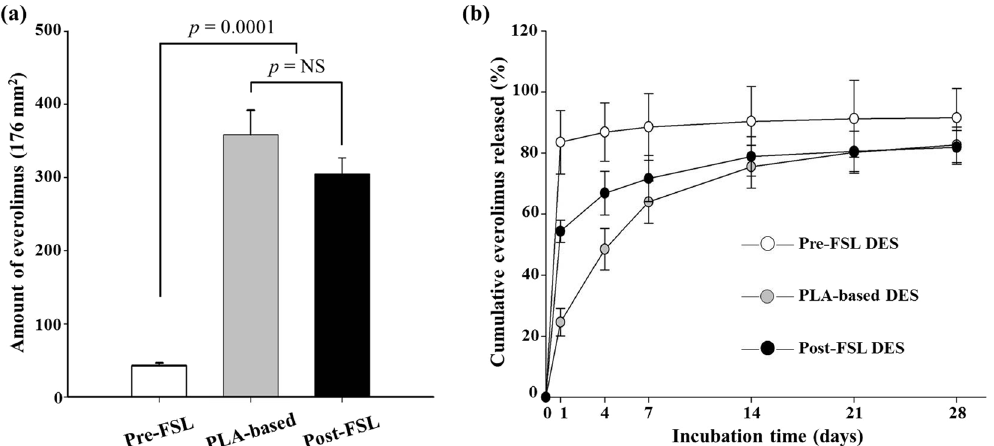
Figure 5. Amount of everolimus on surfaces and in vitro release velocities. The amount of EVL on the stent surfaces after washing with PBS. ( a ) In vitro cumulative EVL released from surfaces. ( b ) The amount of everolimus was measured using UV-visible spectrophotometer at designated time points. The indicated values are expressed as the mean ± SD (n = 10). NS, not statistically of 3-D tubular shaped stents (Fig. S1). In such an equipment system, by adjusting the condition of the jig that is being held, the interval of the desired patterning can be realized. This equipment enabled regulation of pattern thickness and creation of micropores (Fig. 1), indicating the feasibility of directing cell migration 15 and EVL